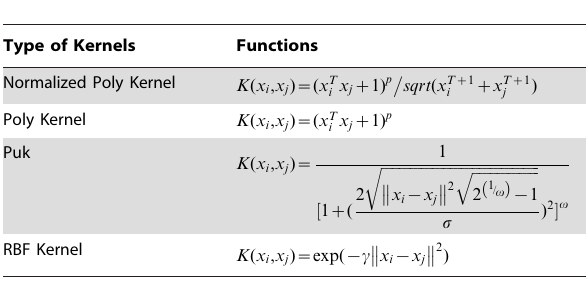
Table 2. Summary of